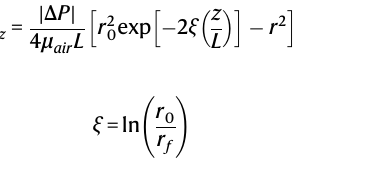
fi ber radii, respectively. L is the preform-to- fi ber transition length. b Color plot of γ eff ∣ Δ P ∣ , and preform-to- fi ber down-ratio, r 0 γ 0 for varying pressure differences, c Graph for γ eff γ as a function of r 0 for ∣ Δ P ∣ r f 0